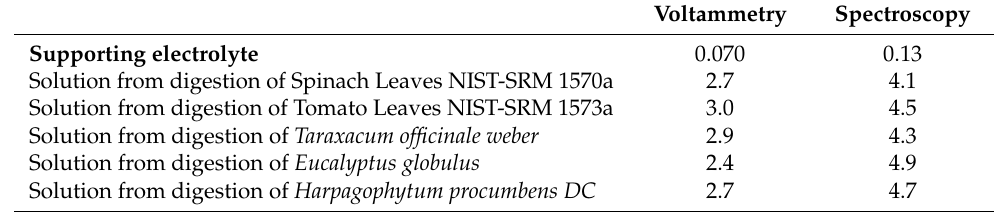
Table 1. Voltammetric and spectroscopic LOD s of Tl(I) determined in the aqueous reference solution ( µ g L − 1 ), in the solutions obtained by digestion of spinach leaves NIST-SRM 1570a and tomato leaves NIST-SRM 1573a, and in the solutions obtained by digestion of real samples (calculated in µ g L − 1 and expressed in µ g kg − 1 ). The determined values are the mean of five independent determinations; confidence level: 95%.